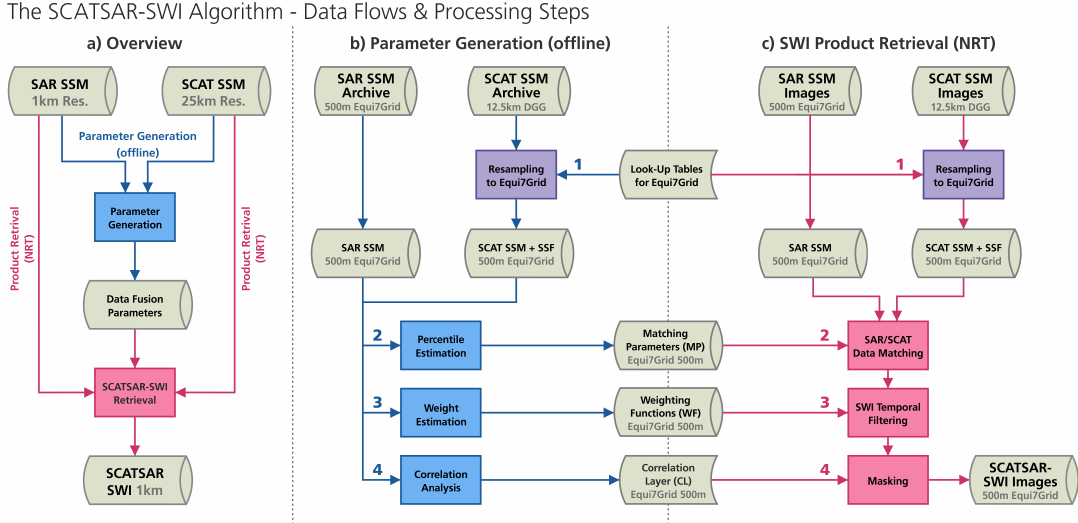
Figure 2. ( a ) overview on the SCATSAR-SWI retrieval algorithm and its data flows, with the offline parameter generation in blue and the near-real-time (NRT) product retrieval in red; ( b ) the parameter generation preparing the data fusion parameters (Matching Parameters, Weighting Functions and Correlation Layer) for the product retrieval, using surface soil moisture (SSM) and surface state flag (SSF) from the input datasets; ( c ) the NRT-capable SWI product retrieval, taking up incoming SSM data as well as prepared data fusion